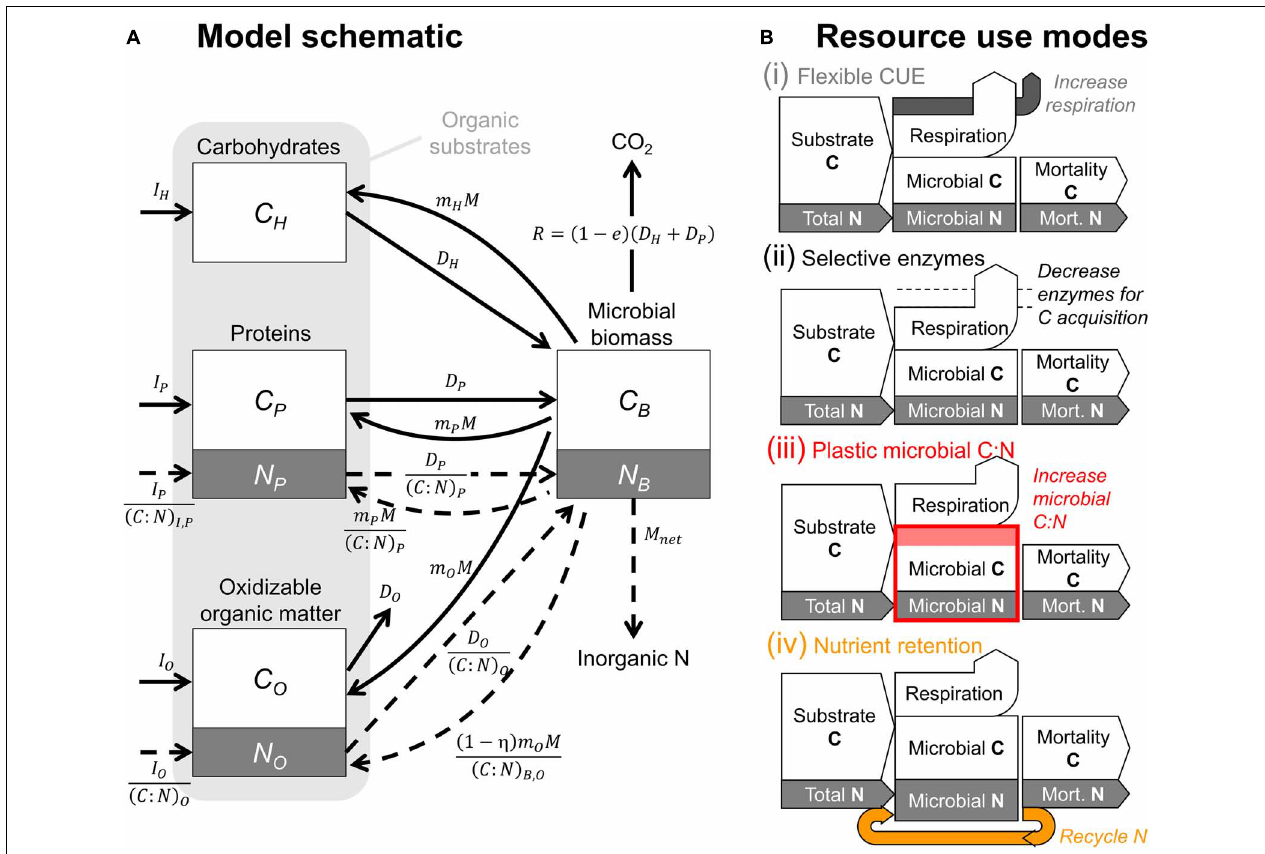
FIGURE 1 | (A) Model schematic. White and gray boxes represent the modeled carbon (C) and nitrogen (N) compartments; solid and dashed arrows represent C and N flow rates, respectively (straight arrows refer to input, decomposition, and mineralization rates; curved arrows refer to recycling of microbial residues in the substrate compartments). (B) Simplified representations of the four resource use modes implemented in the model shown in panel (A) (color-coded as in Figures 2 – 6 , 9 ). The text in italic explains the response to N limitation in each mode; the label “Total N” indicates N supply to microbes from both organic substrates and the inorganic N